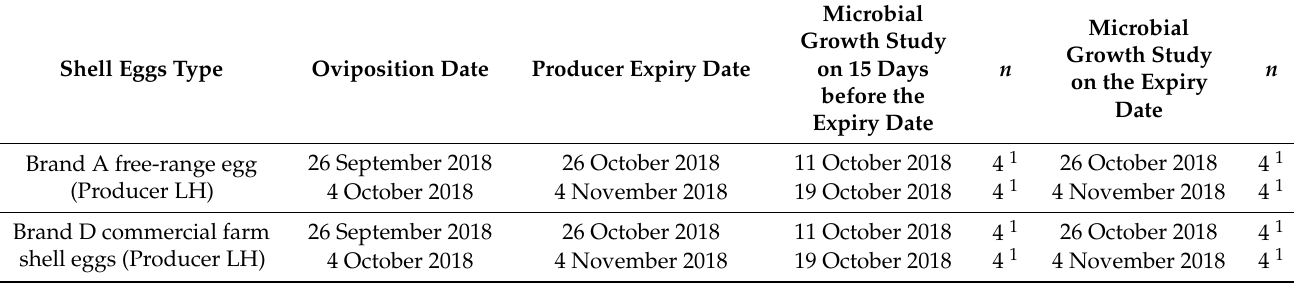
Table 3. Storage duration for the post-treatment microbial load